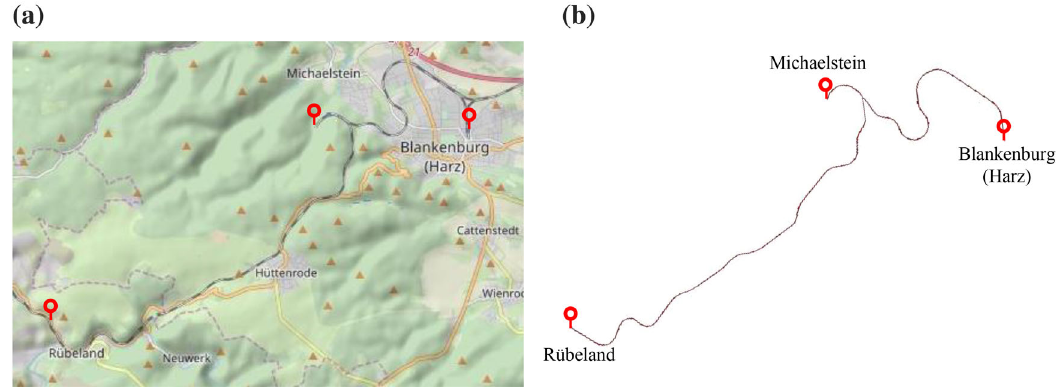
Fig. 9 Ru¨beland–Blankenburg railway line: a the satellite map, and b the plan view of the line simulated in SIMPACK